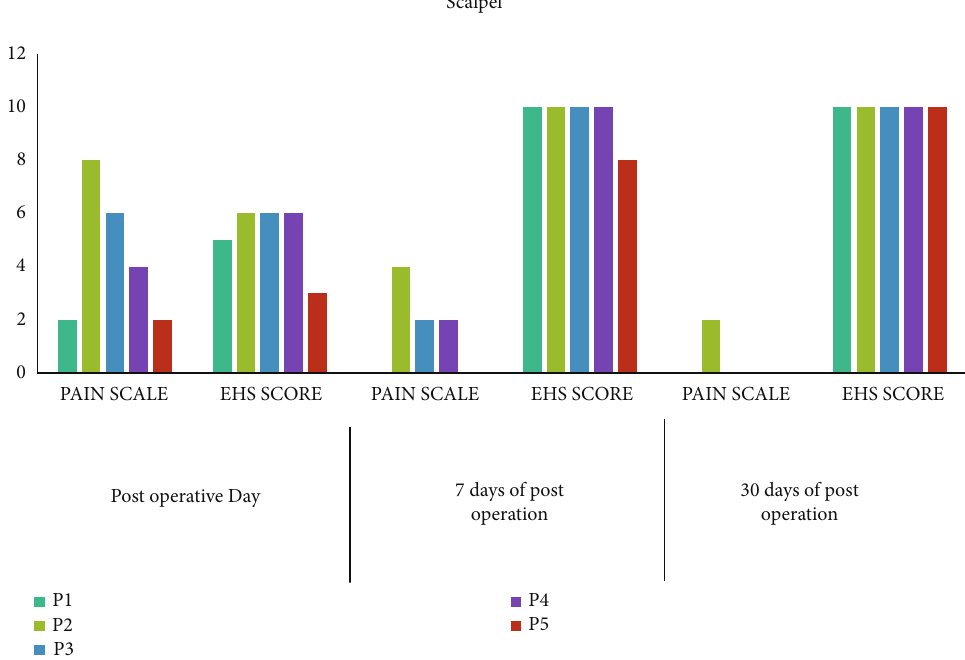
Figure 2: Pain scores of scalpel-treated patients.